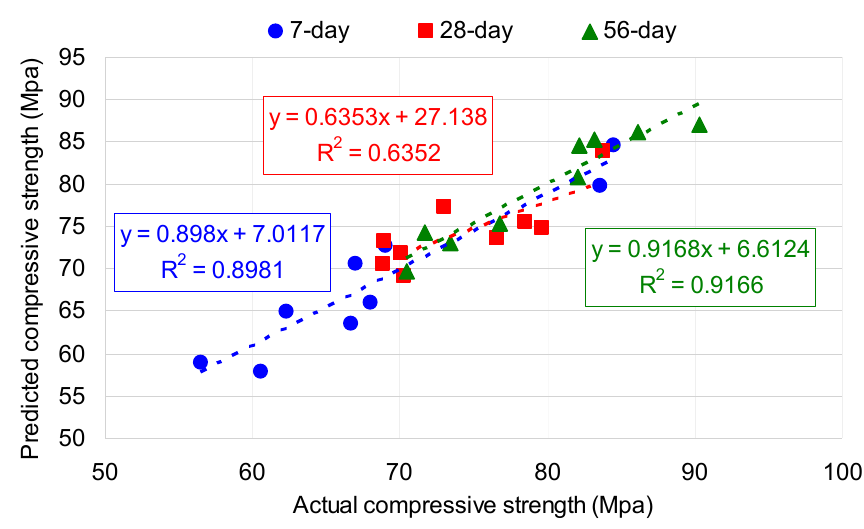
Figure 14. Regression analyses for predicted vs. actual strength values.